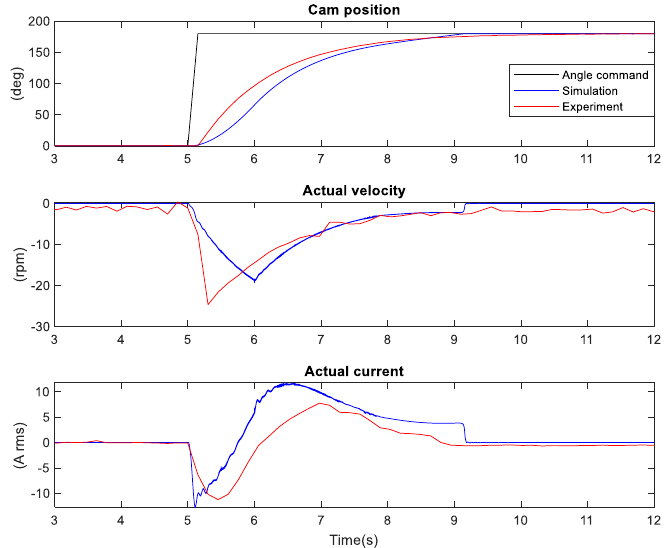
Figure 12. Validation of the co-simulation model with the experimental results of the track switch system, working by single actuator bearer (third bearer B3, motor side-B).